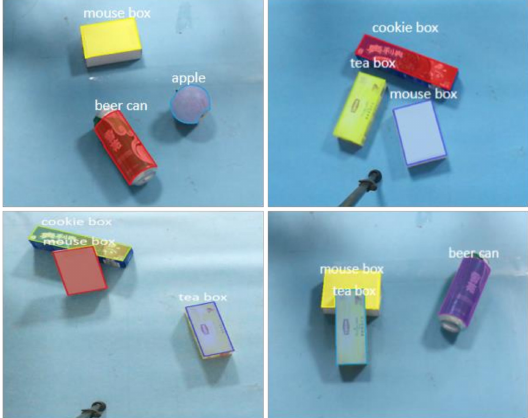
Figure 11. Instance segmentation